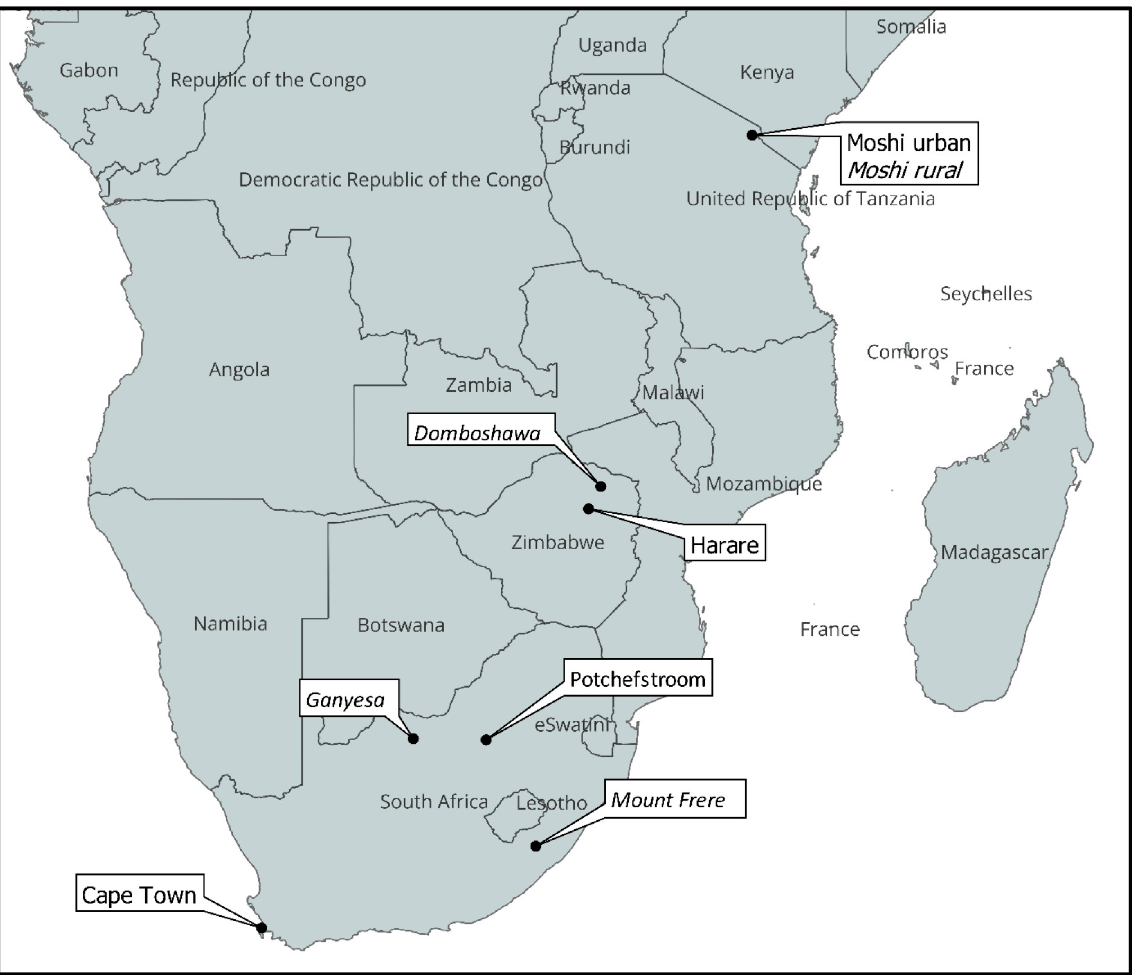
Fig 1. Map of study locations. Rural sites in italics. Source: https://www.naturalearthdata.com/downloads/10m-cultural-vectors/. Licence: CC0 1.0 Universal (CC0 1.0) Public Domain Dedication.